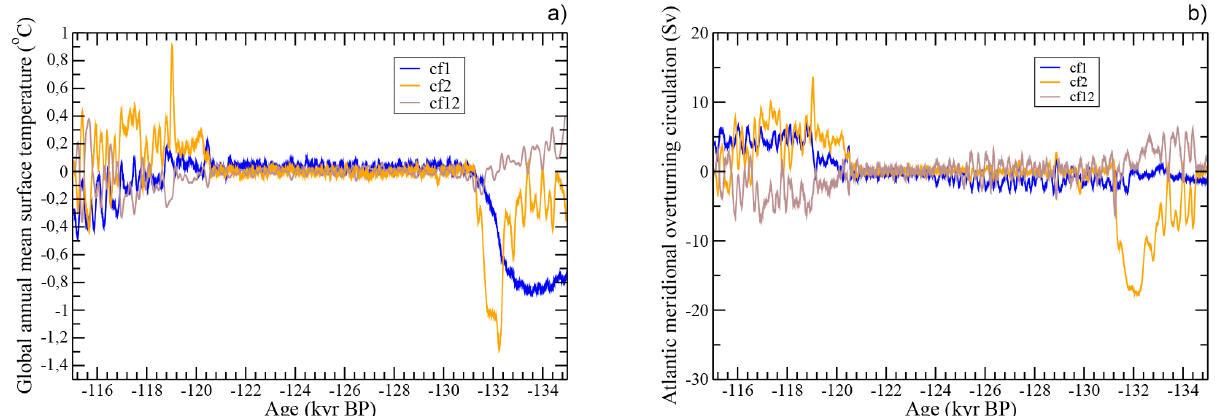
Figure 12. Separation factor method applied to the global annual mean surface temperature (a) and the AMOC (b) . The pure contribution of the ice sheets configuration (cf1 in blue), of the additional freshwater flux related to the melting of the ice sheets (cf2 in orange) and of the synergism between the two factors (cf12 in